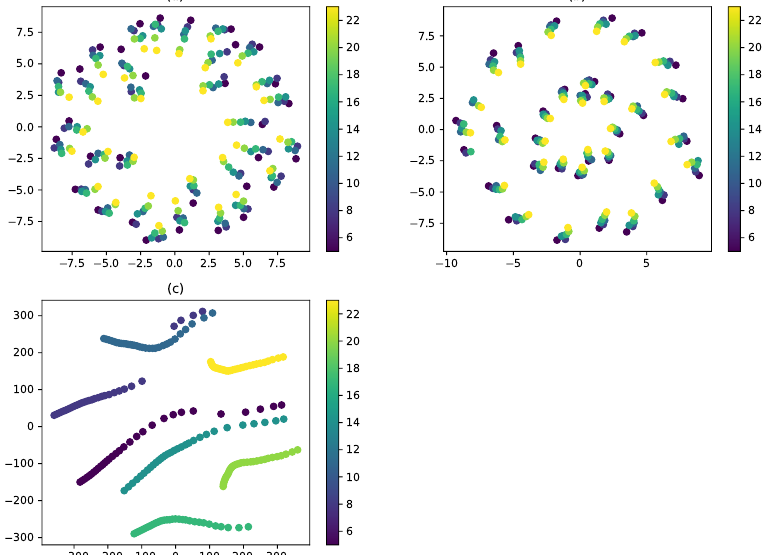
Figure 20. tSNE graph for seven different torque conditions on bolt 5 using different data sets. ( a ) D1, ( b ) D2, and ( c )